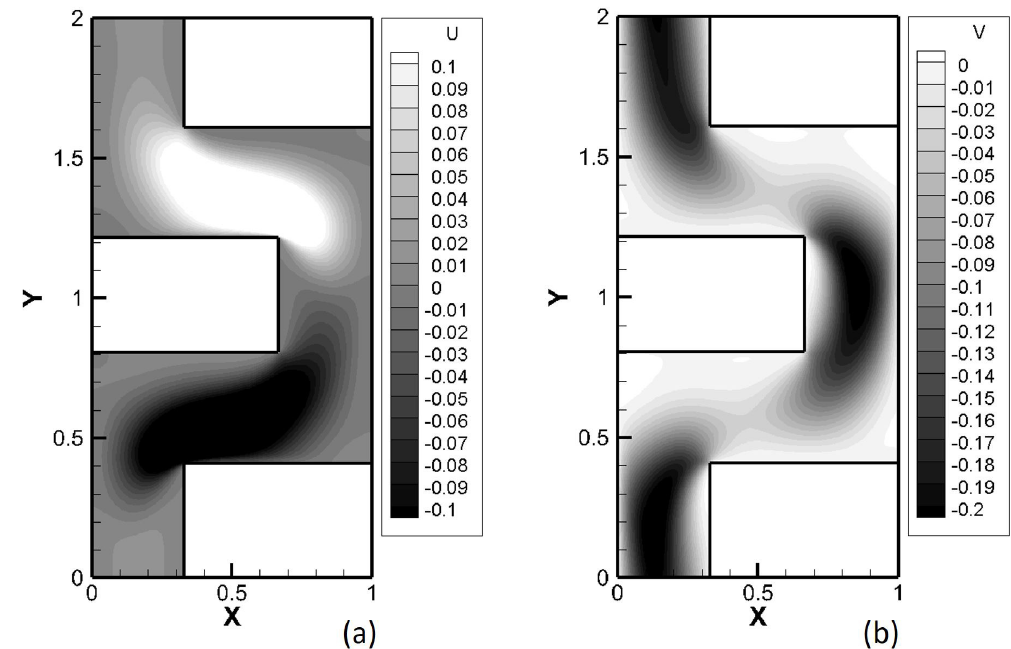
Figure 4. Two-dimensional flow characteristics inside a multiple right bending pipe driven by gravitational force: contour plots of ( a ) horizontal velocity; ( b ) vertical velocity.